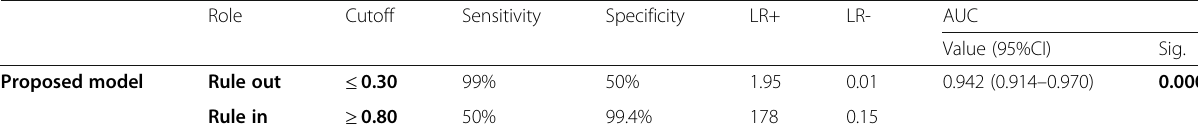
Table 5 Receiver operating characteristics of the proposed model Role Cutoff Sensitivity